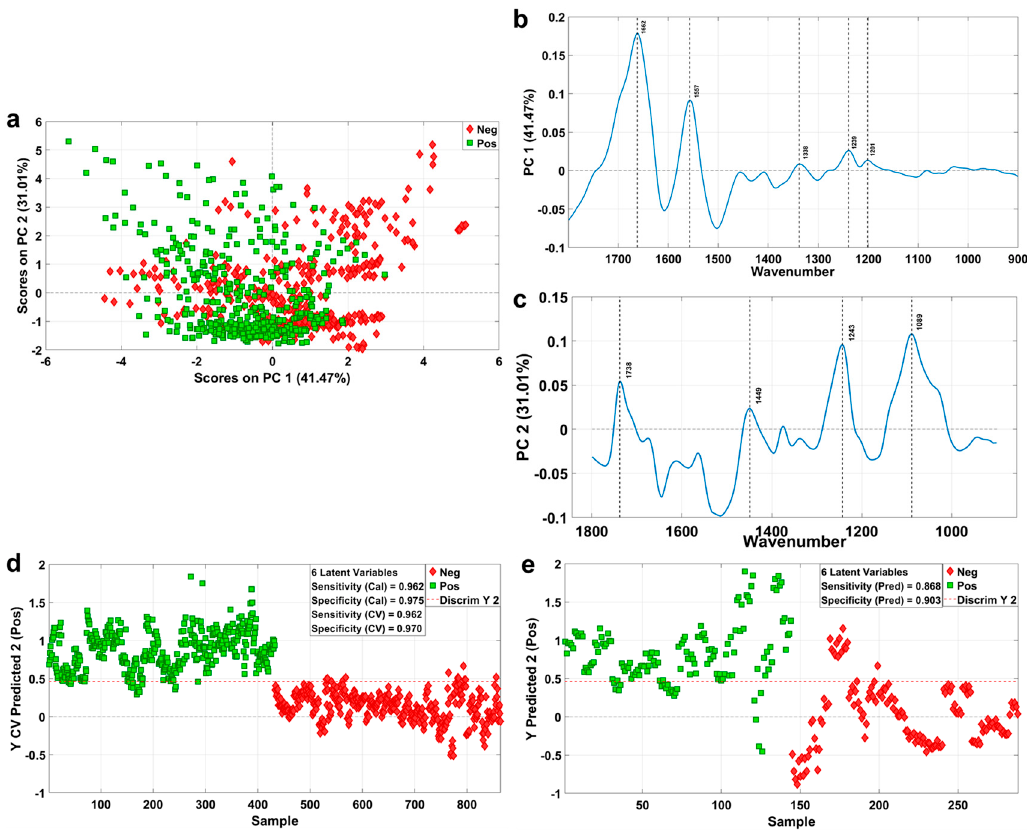
Figure 4. Classification model of human muscle trauma and its accuracy index. ( a ) PCA scores in the direction of PC1 and PC2 of the trauma group and the control group. The green markers are trauma-positive group, and the red markers are negative control group. ( b ) Loading plot on PC1 from PCA analysis, marked with significant peaks. ( c ) Loading plot on PC2 from PCA analysis, marked with significant peaks. ( d ) Trauma classification model and sensitivity and specificity indexes established based on training sets of trauma group and control group. The green markers are trauma-positive group, and the red markers are negative control group. ( e ) Trauma classification prediction model and related evaluation model indexes established based on the test sets of trauma group and control group. The green markers are trauma-positive group, and the red markers are negative control